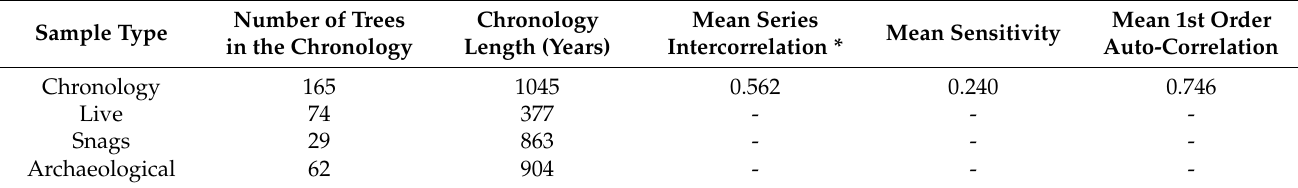
Table 1. Final master chronology statistics from the study. * Note the series intercorrelation is based on overlapping 50-year